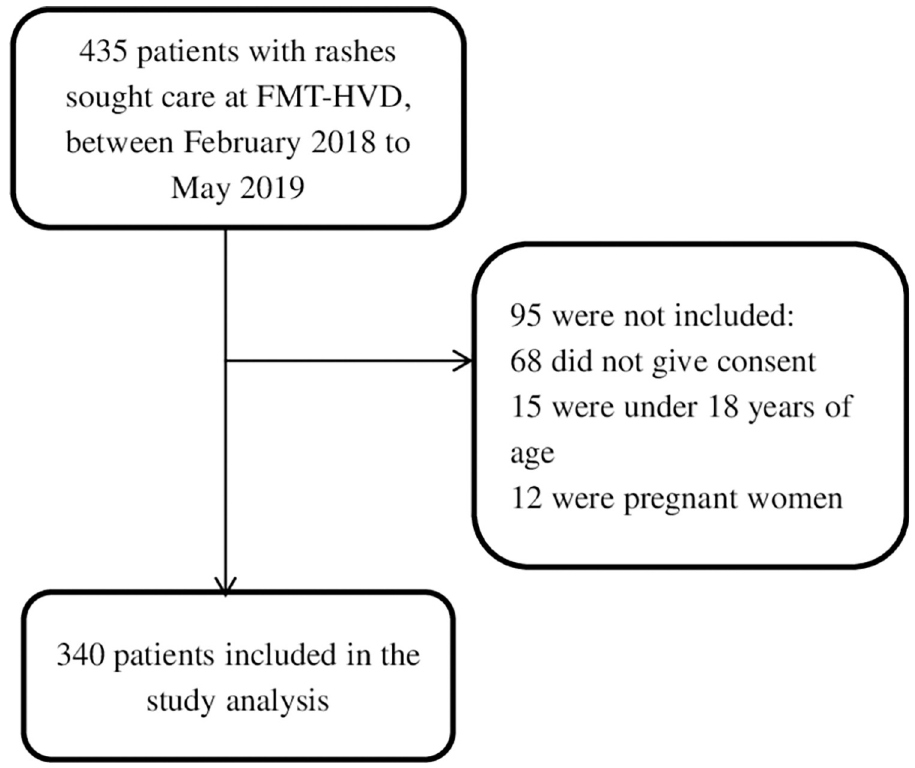
Fig 1. Flowchart of inclusion of patients treated at FMT-HVD for skin